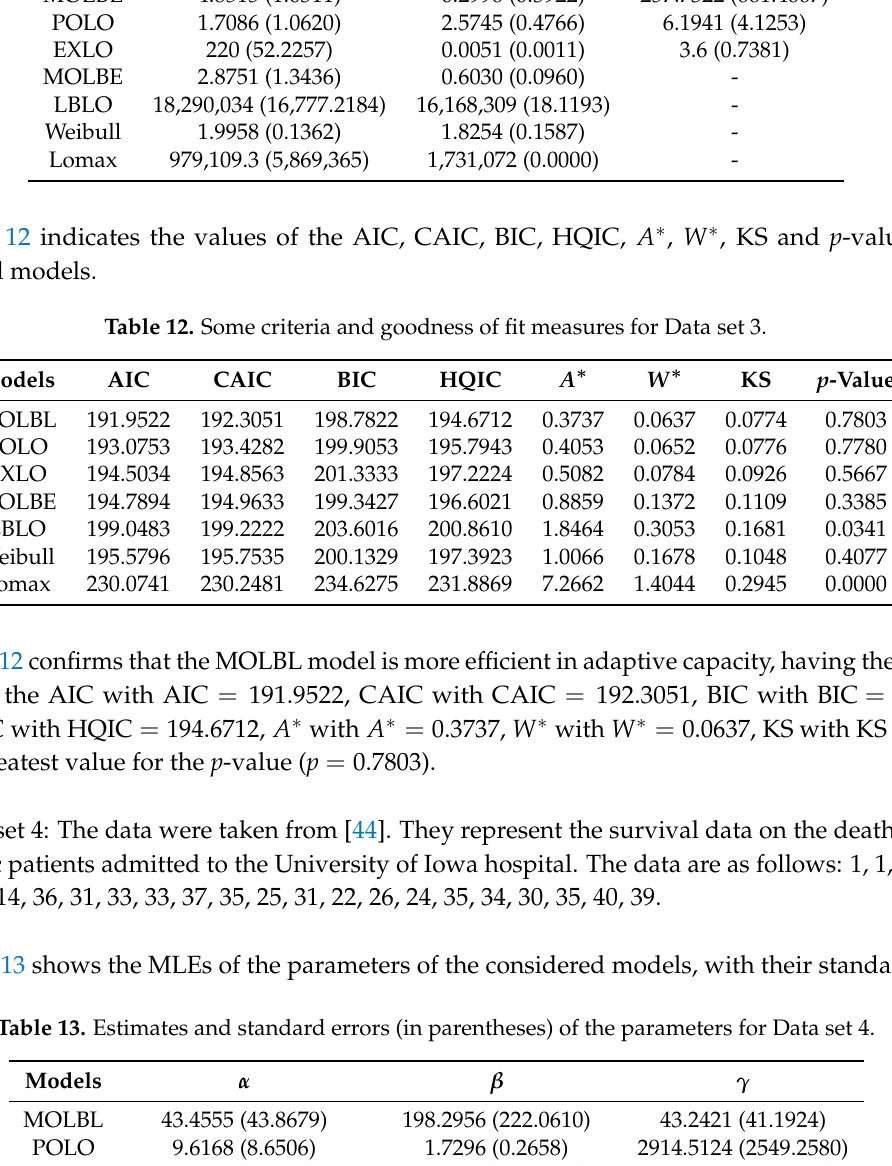
Table 13. Estimates and standard errors (in parentheses) of the parameters for Data set 4. Models